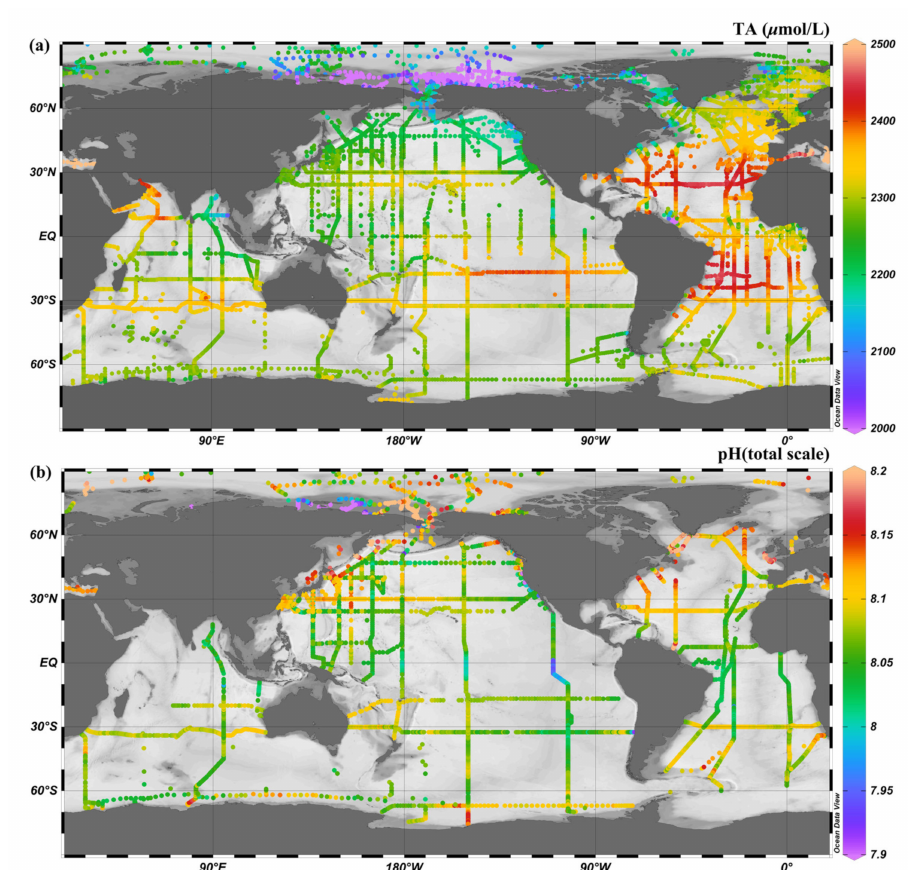
Figure 2. Spatial distribution of used carbonate parameters from the GLODAP dataset. In situ ( a ) TA and ( b ) pH variation from 1992 to 2019. The WOCE quality control flags for both TA and pH are 2